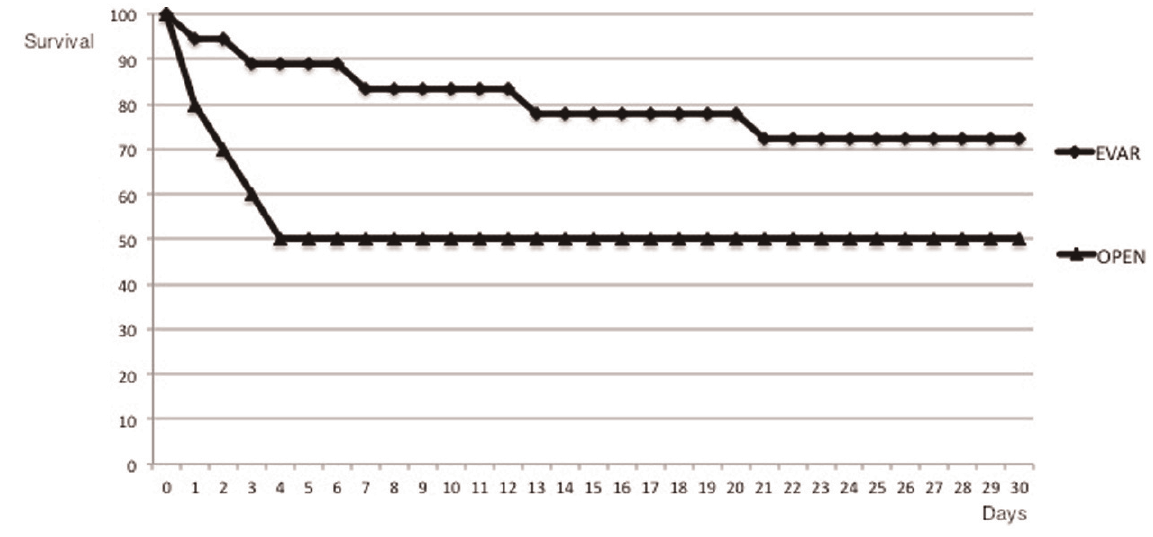
Figure 2 - Survival rate (Kaplan-Meier) of patients who underwent REVAR or OPEN repair to treat a ruptured abdominal aortic